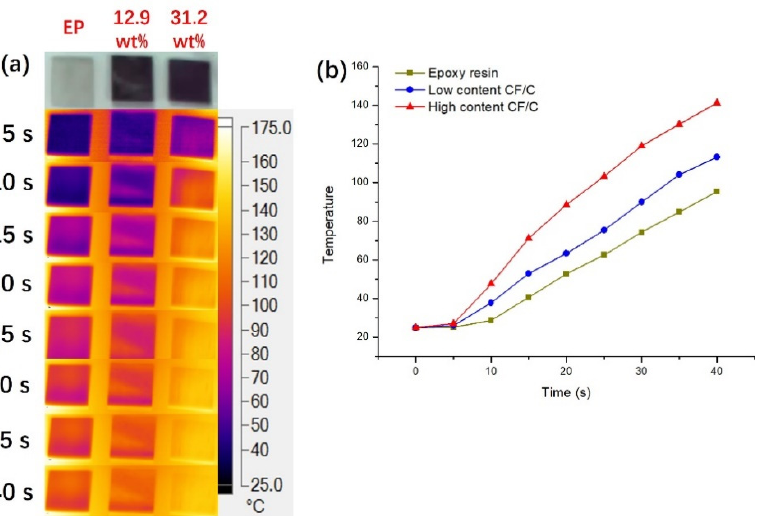
Figure 8. ( a ) Infrared thermal image, ( b ) the surface temperature of different CF/C/EP composites with time during heating.